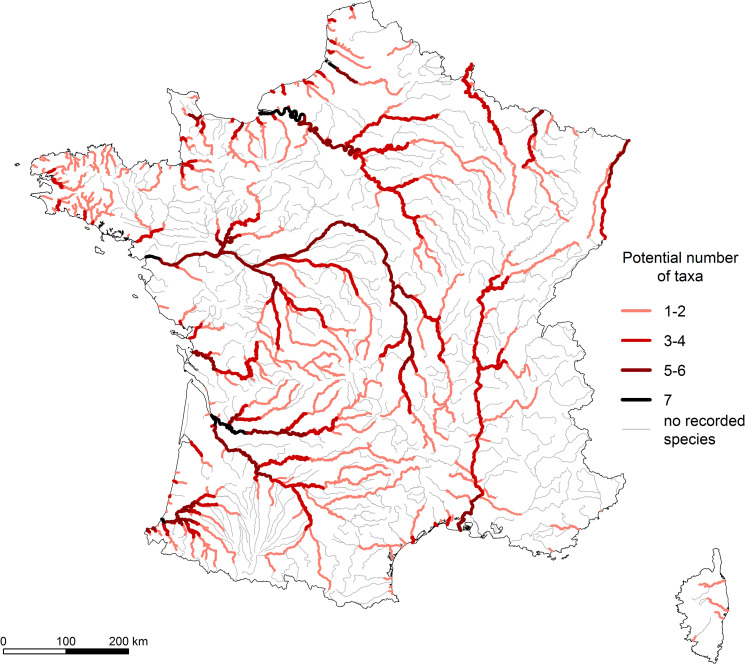
Potential richness of diadromous fishes in France.The potential number of taxa was calculated considering historical and current data. River segments without any known historical or current data appear as "no recorded species" segments.